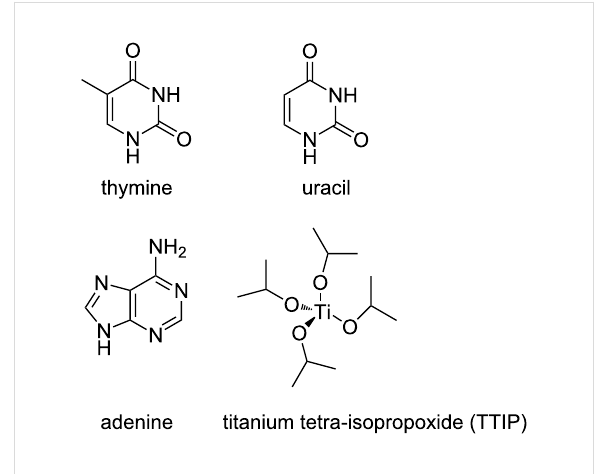
Figure 1: The organic and inorganic molecules used as precursors in the current